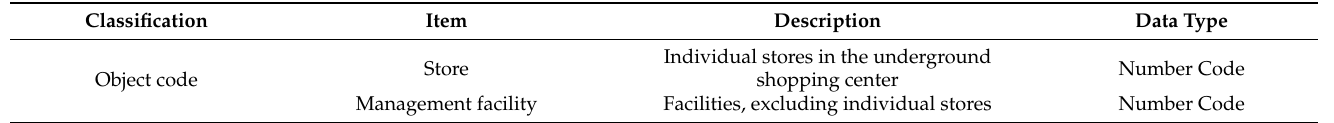
Table A1. Attribute specification of underground shopping center